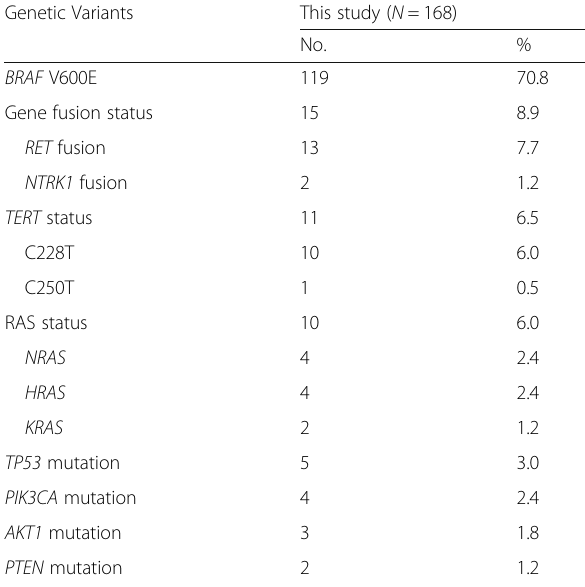
Table 2 Genetic variants of 168 PTC patients in southern Chinese